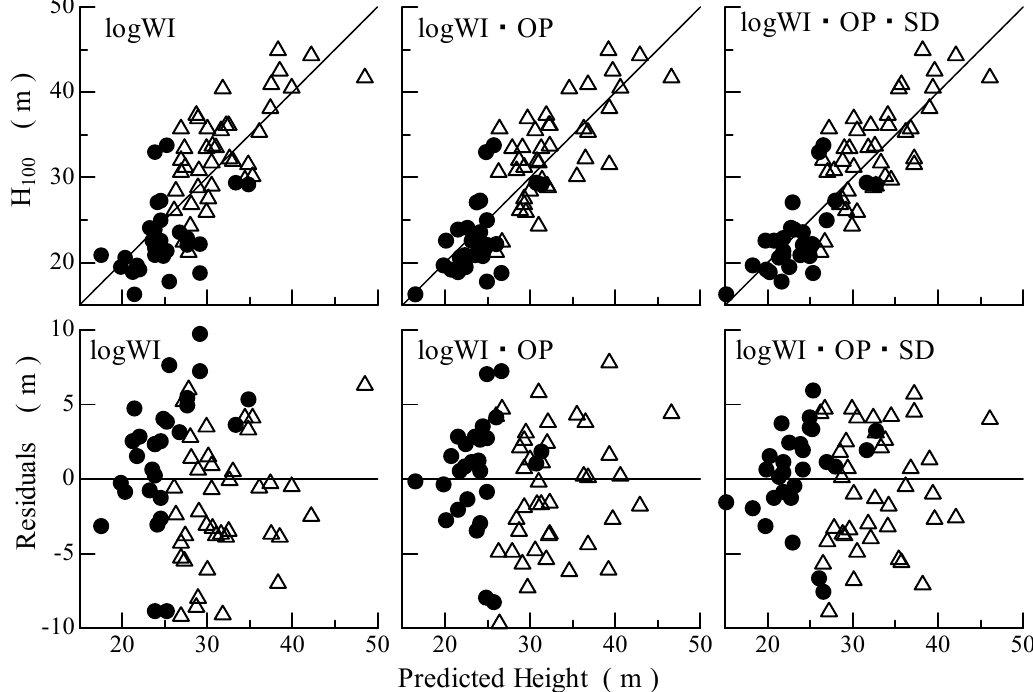
Figure 2. Tree height (H 100 ) prediction using multiple regression analysis with the wetness index (H 100 = 45.7 logWI + 0.46; aR 2 = 0.60; AIC = 402), the wetness index and openness (H 100 = 33.0 logWI – 0.26 OP + 29.8; aR 2 = 0.69; AIC = 386), and the wetness index, openness, and soil depth (H 100 = 31.5 logWI – 0.28 OP + 2.34 SD + 28.0; aR 2 = 0.73; AIC = 378) ( n = 68). Filled circles indicate plots on the ridges and, open triangles indicates plots on the middle or lower sections of the slopes. aR 2 : coefficient of determination adjusted by the number of parameters.